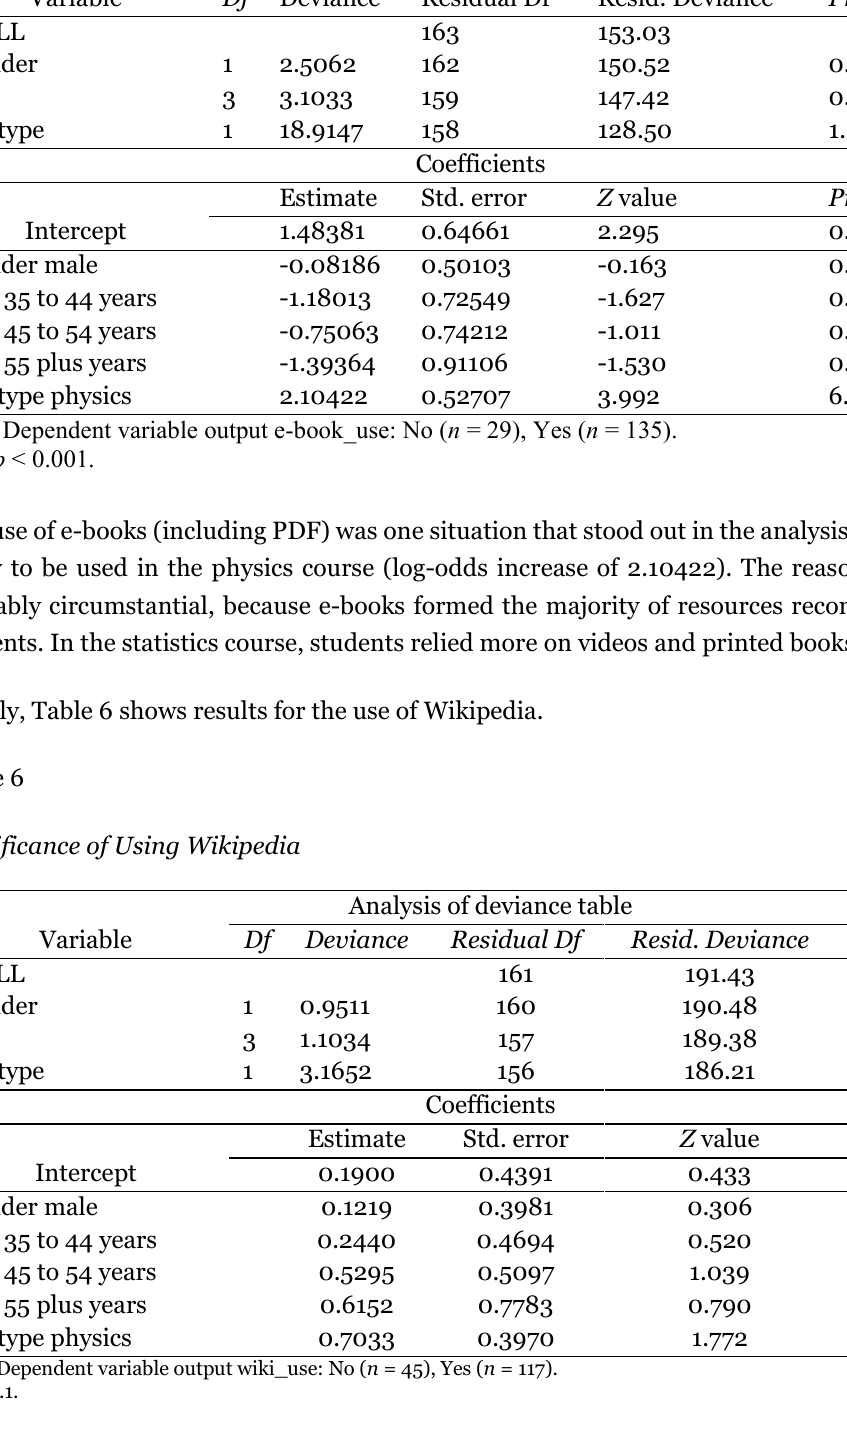
Significance of Using e-Books